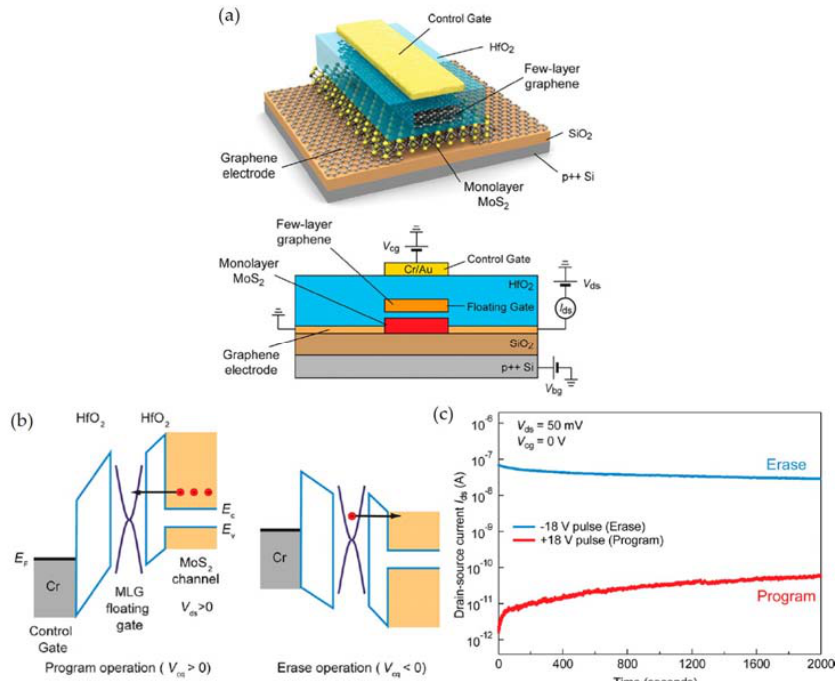
Figure 22. MoS 2 /graphene heterostructure memory device layout. ( a ) Three-dimensional schematic view of the memory device based on single-layer MoS 2 . Lower is the schematics of a heterostructure memory cell with a single-layer MoS 2 semiconducting channel, graphene contacts and MLG floating gate. The MLG floating gate is separated from the channel by a thin tunneling oxide (1 nm Al 2 O 3 + 6 nm HfO 2 ) and from the control gate by a thicker blocking oxide (1 nm Al 2 O 3 + 30 nm HfO 2 ). ( b ) Simplified band di+agram of the Cr/HfO 2 /Gr/HfO 2 /MoS 2 heterostructure in program and erase operation. ( c ) Temporal evolution of drain–source currents (I ds ) in the erase (ON) and program (OFF) states. The curves are acquired independently for the program (10 − 8 –10 − 7 A) and erase (10 − 12 –10 − 10 A) current states and plotted on a common time scale. The drain–source bias voltage (V ds ) is 50 mV, and the duration of the control-gate voltage (V cg ) pulse is 3s. Reproduced with permission from [252], American Chemical Society,